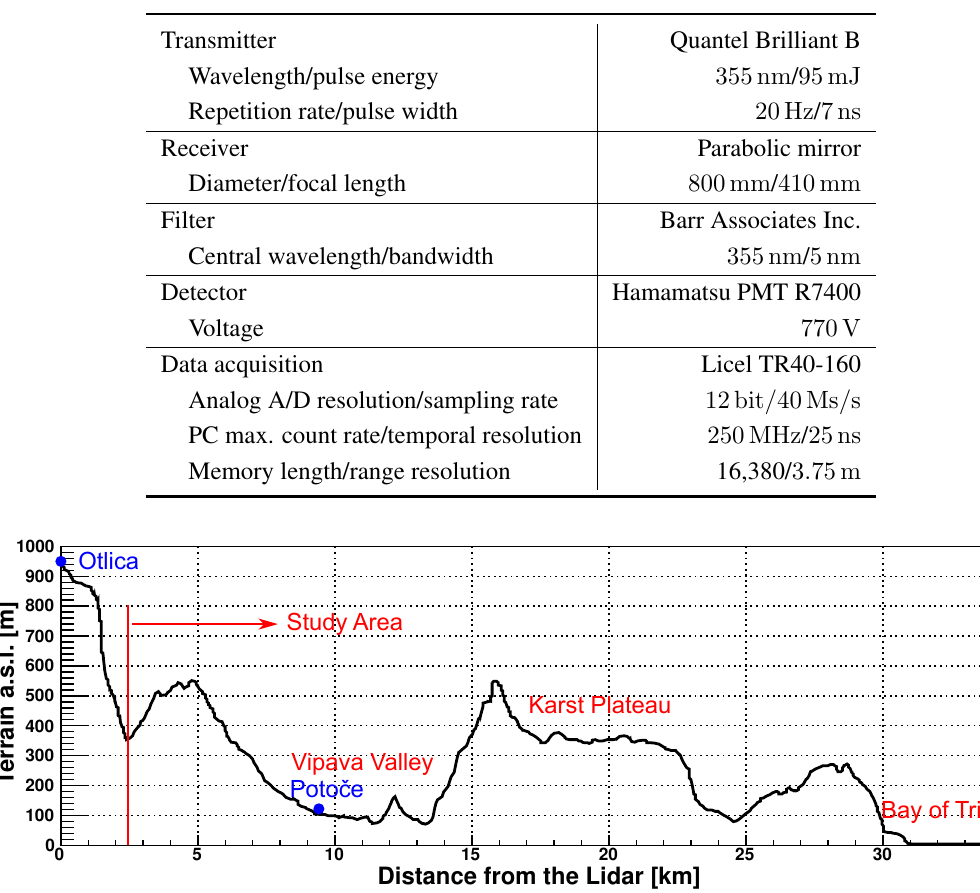
Table 1. Specifications of the scanning elastic backscatter LiDAR systems. PMT, photomultiplier tube.